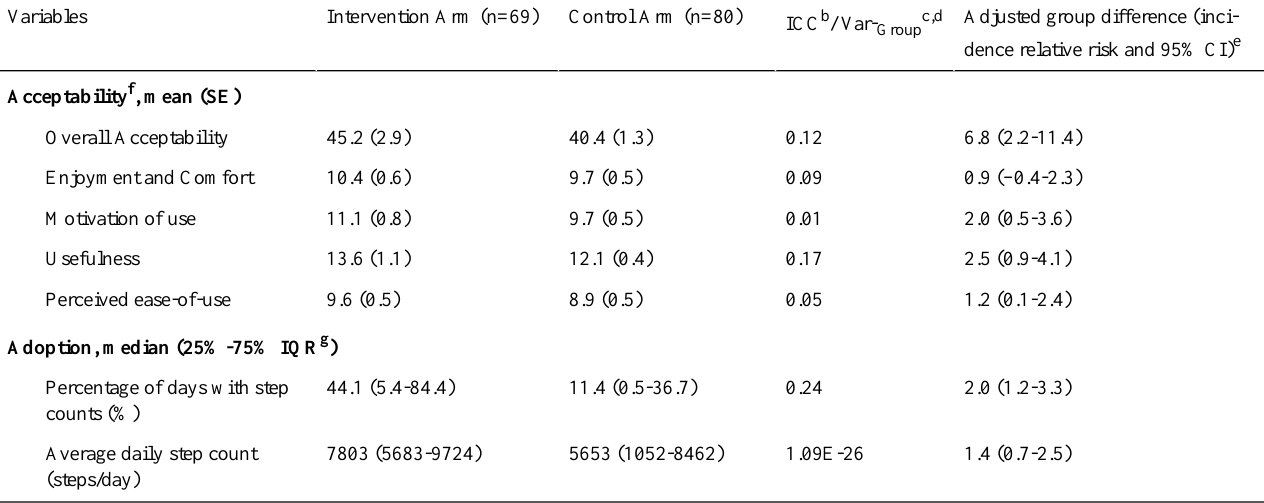
Table 2. Participant acceptability and adoption with activity trackers according to intervention status (N=149) a .